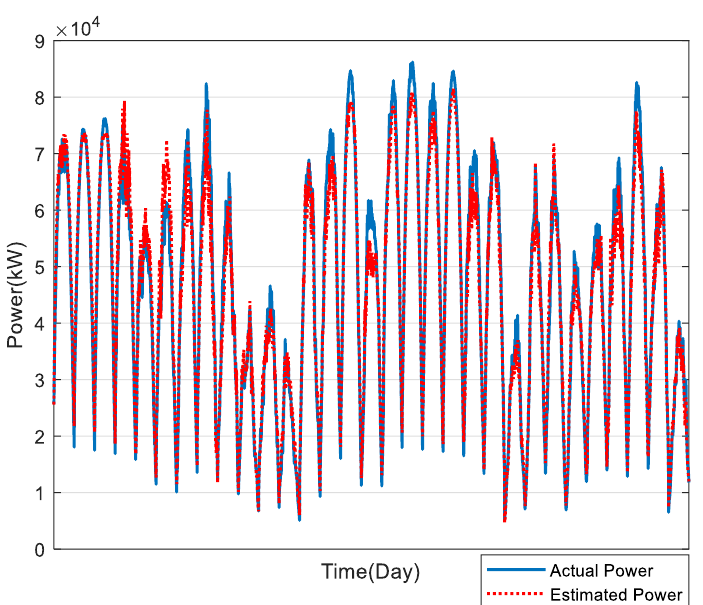
Figure 10. Results of PV power estimation in December.